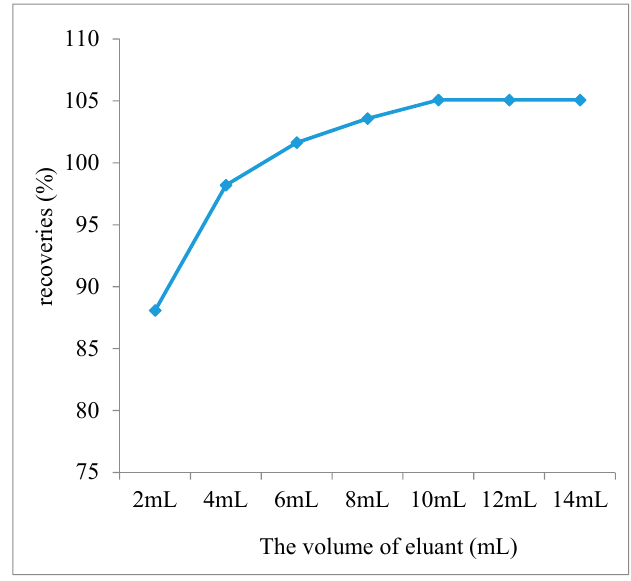
Figure 3. The elution curve of pyrethrins.